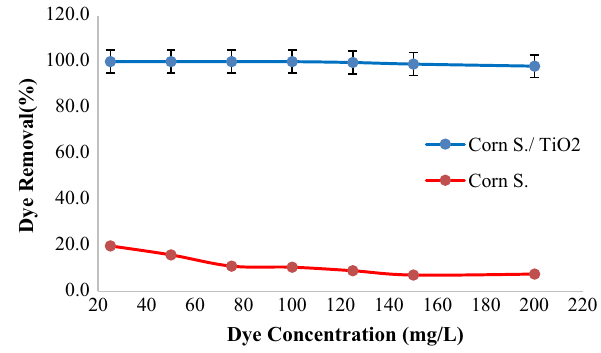
Fig. 9 Effect of dye concentration on the photocatalytic removal rate